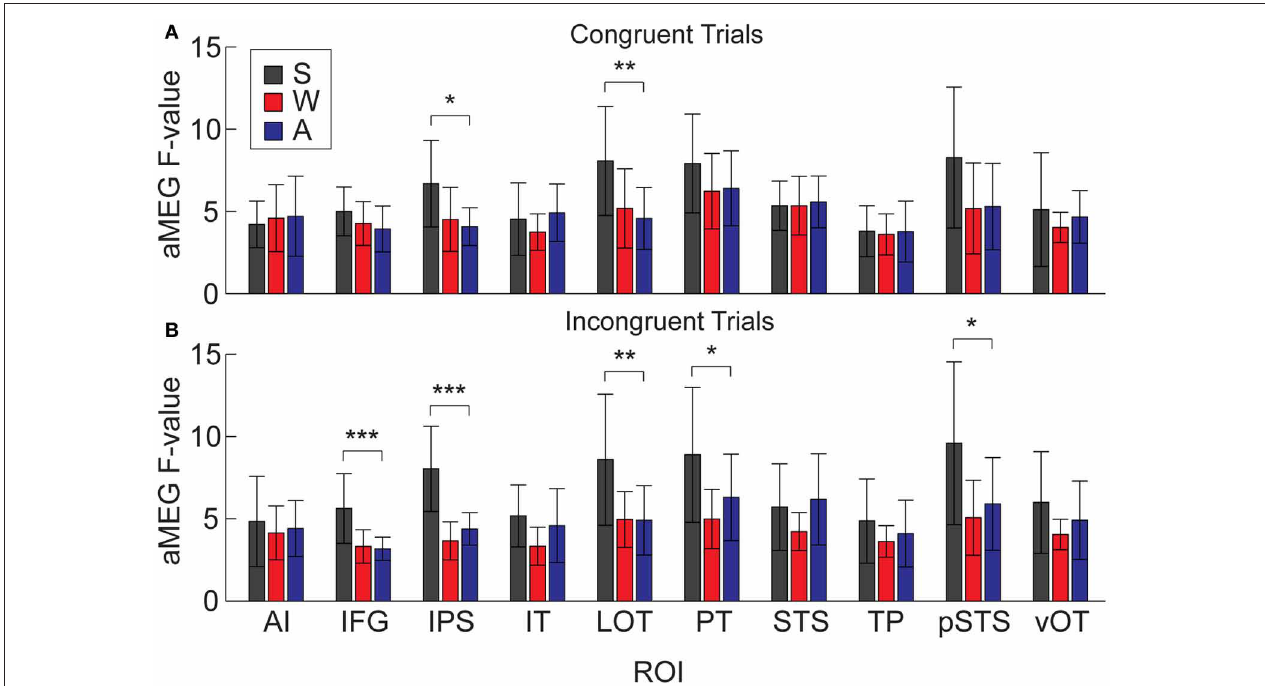
FIGURE 9 | Mean dSPM values for all 10 right hemisphere ROIs, analyzed separately for congruent and incongruent trials. (A) One-Way ANOVAs testing for differences across modalities on congruent